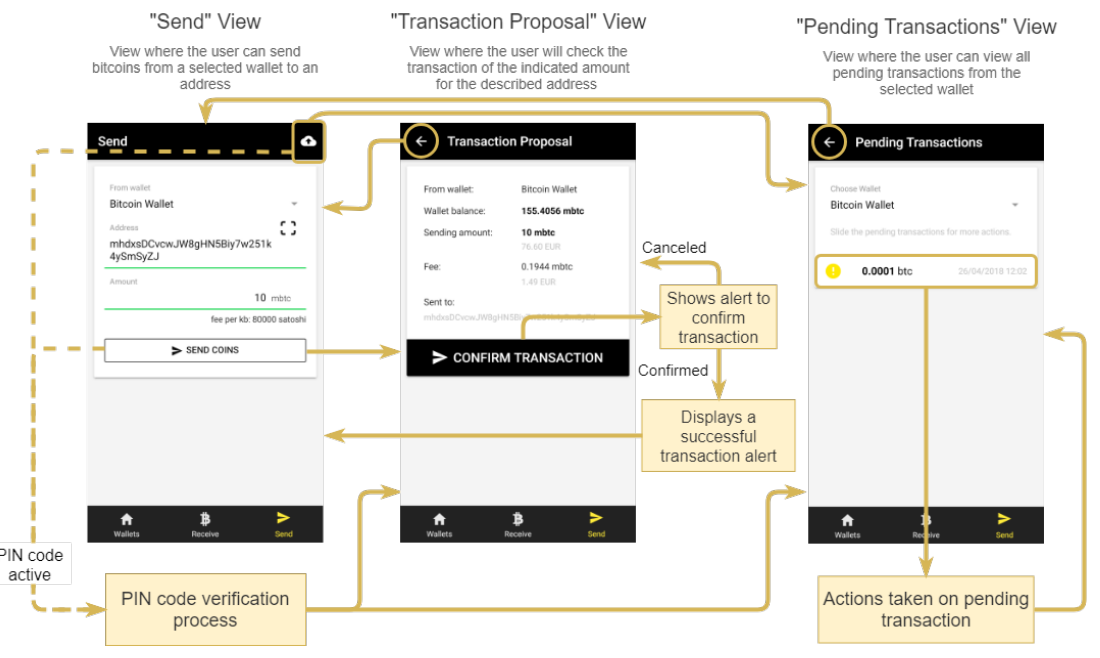
Figure 11. Navigability diagram of the “Send” view.